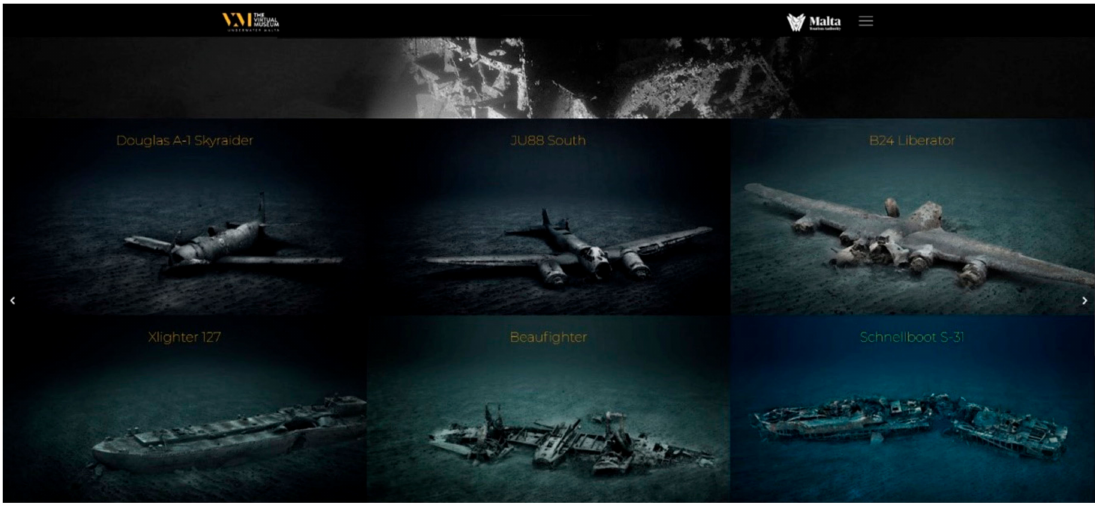
Figure 11. “Artistic impressions” as represented on